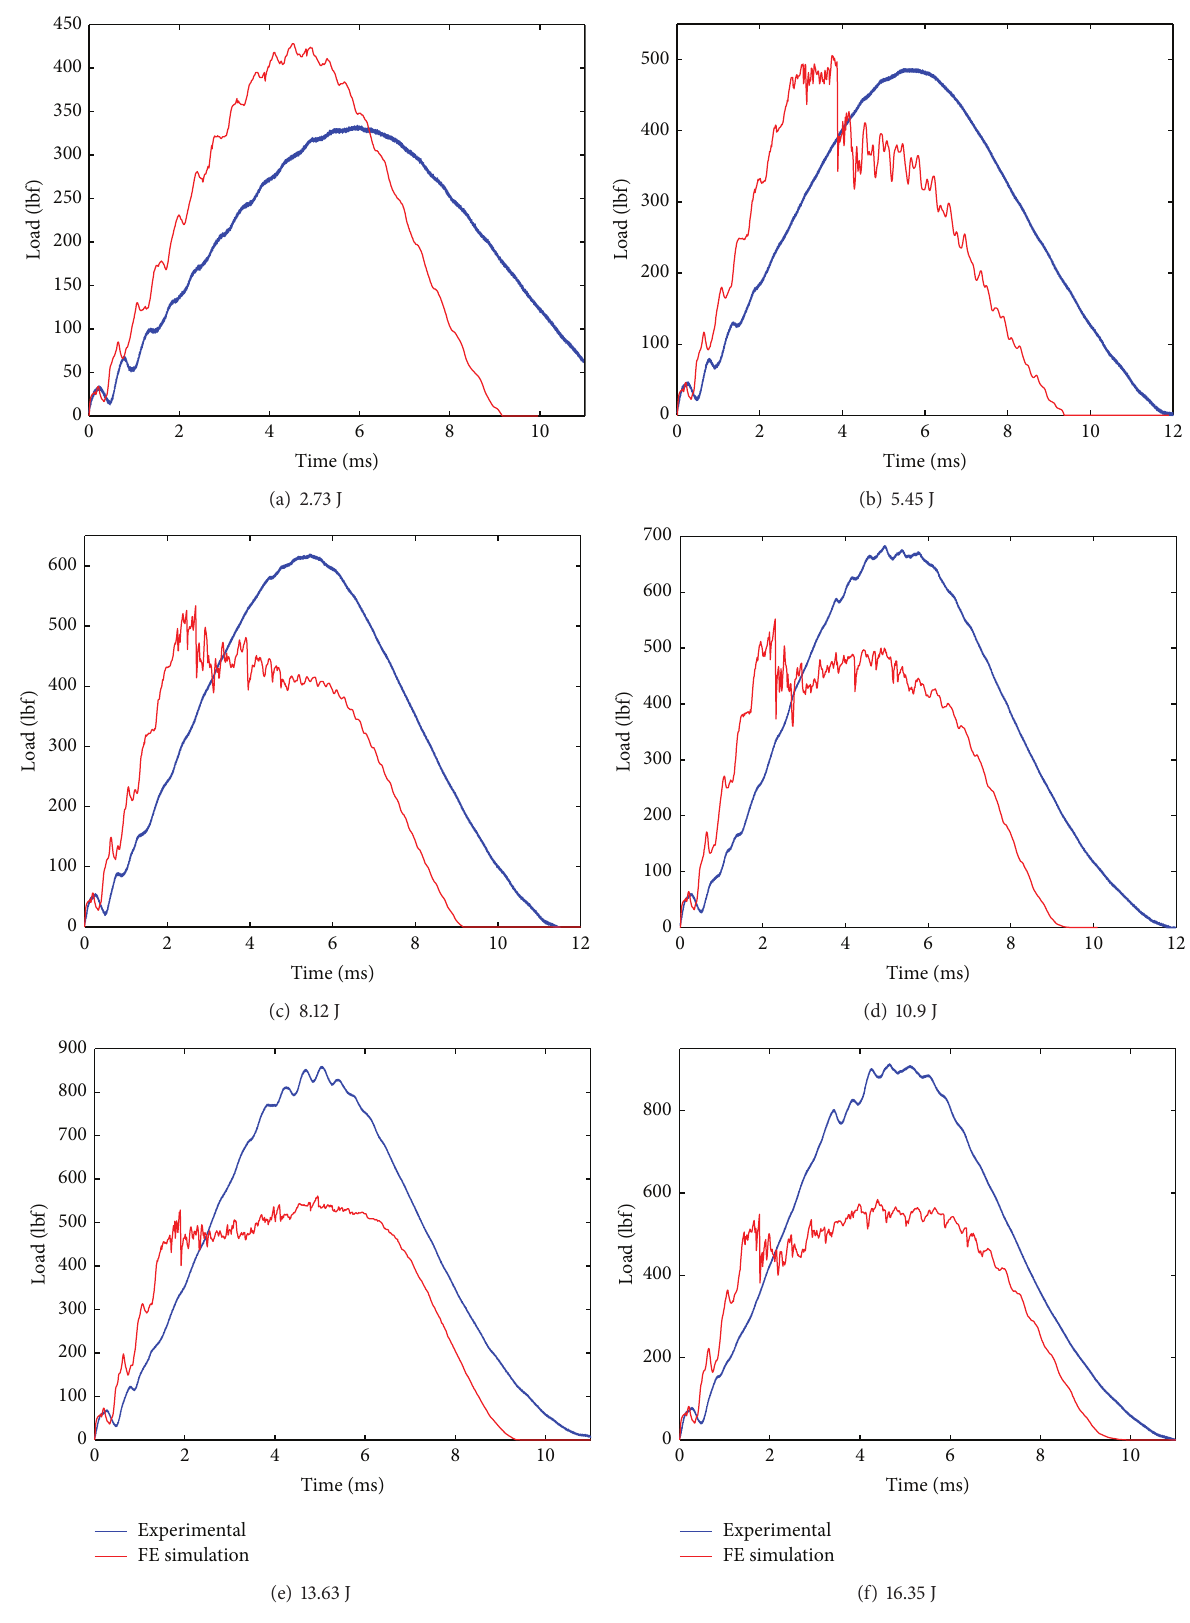
Figure 10: Impact load versus time plots for Hybrid181/Epoxy laminates at six impact energy